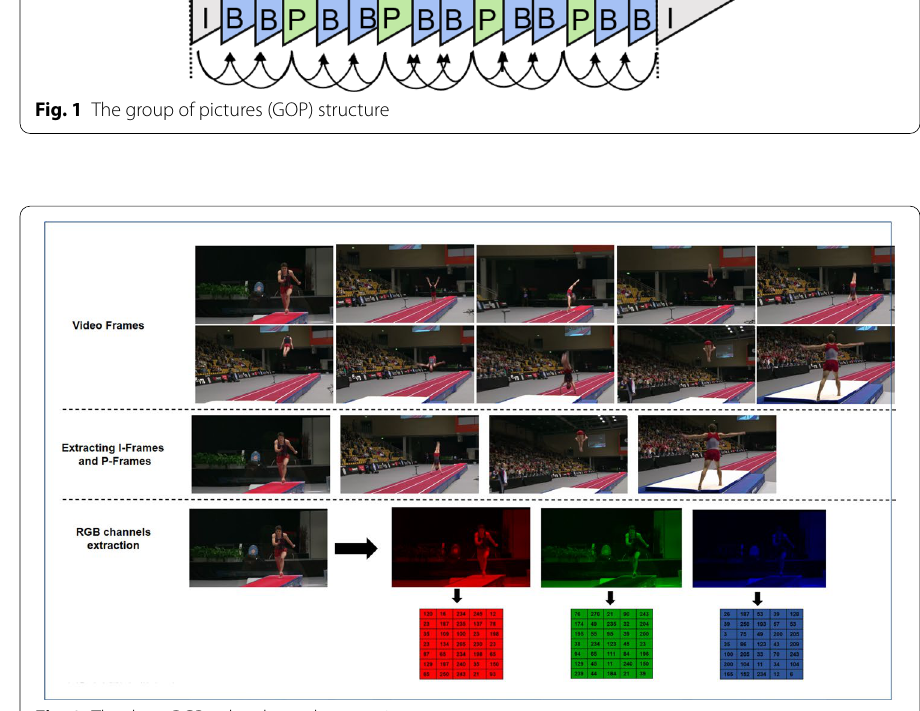
Fig. 2 The three RGB color channels